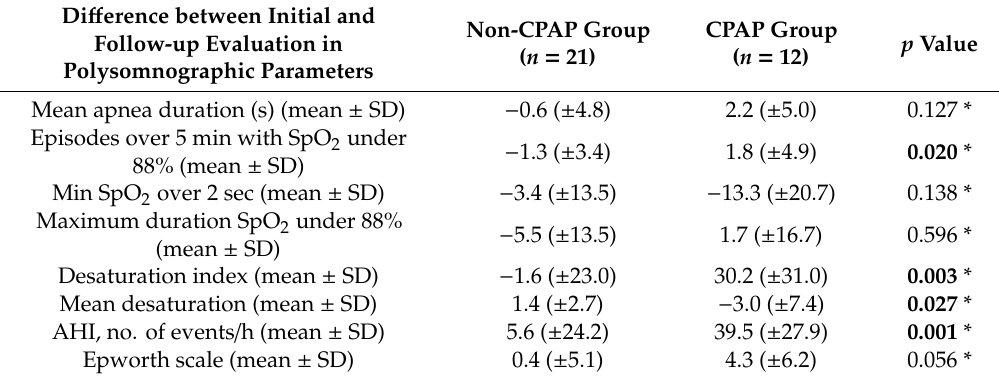
Table 6. Evolution of polysomnographic parameters between initial evaluation and follow-up. Di ff erence between Initial and Follow-up Evaluation